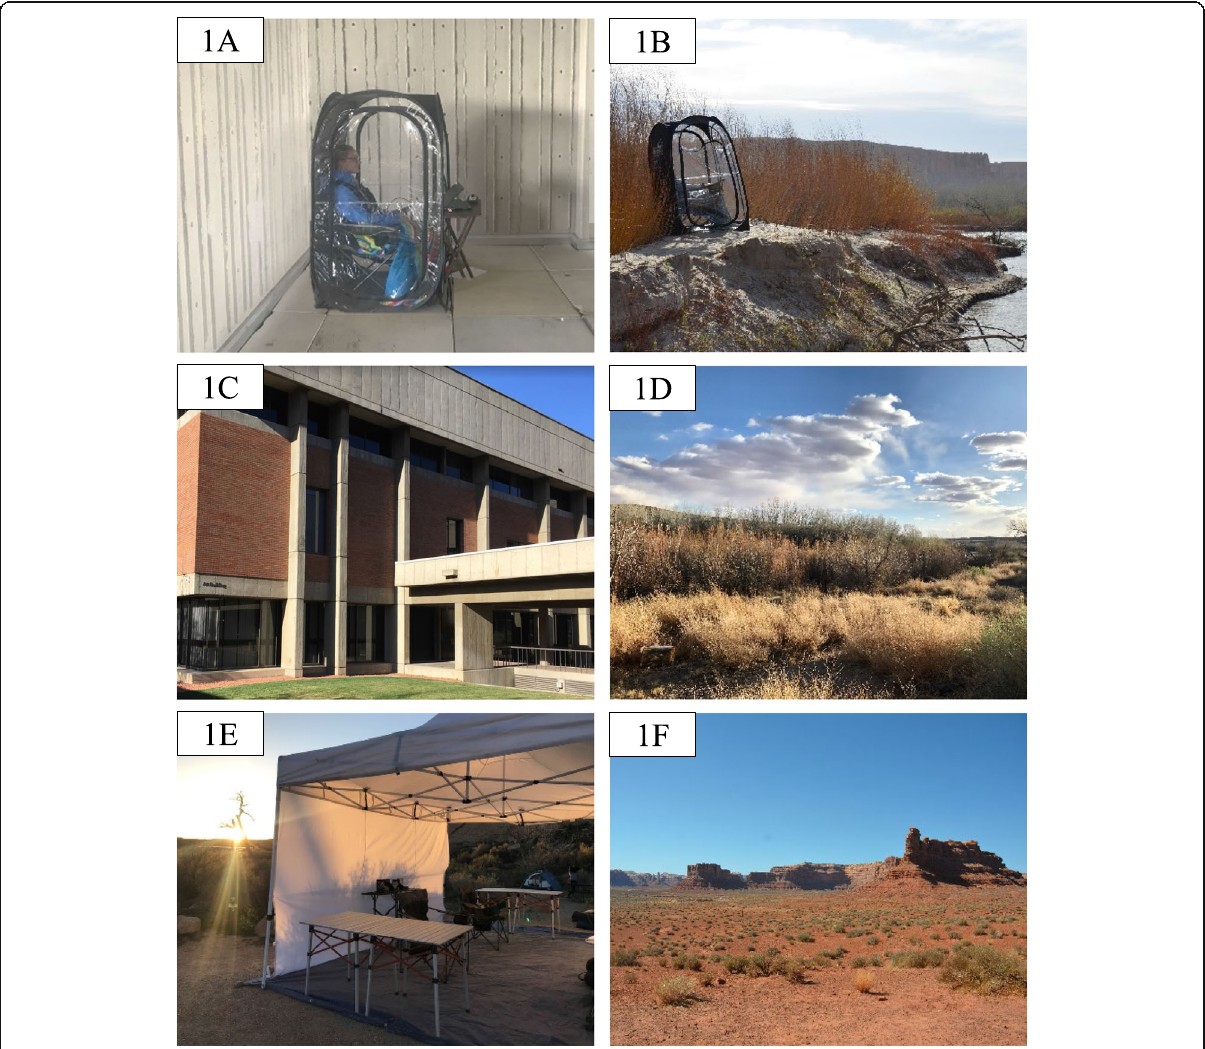
Fig. 1 Example images from the research study. a : Example of participant in weather-protecting pod in the pretrip and post-trip setting. b : Example of participant in weather-protecting pod in the nature trip setting. c . Example view of pre-trip and post-trip environment. d . Example view of nature trip environment. e . EEG preparation setup at the nature trip. f . San Rafael Swell hiking